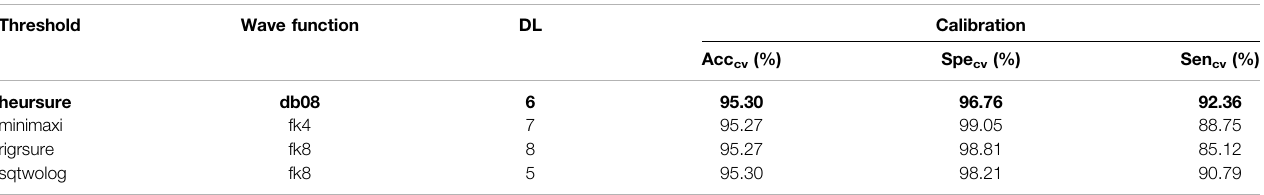
The meaning of the bold values is the best processing method for PLS-DA